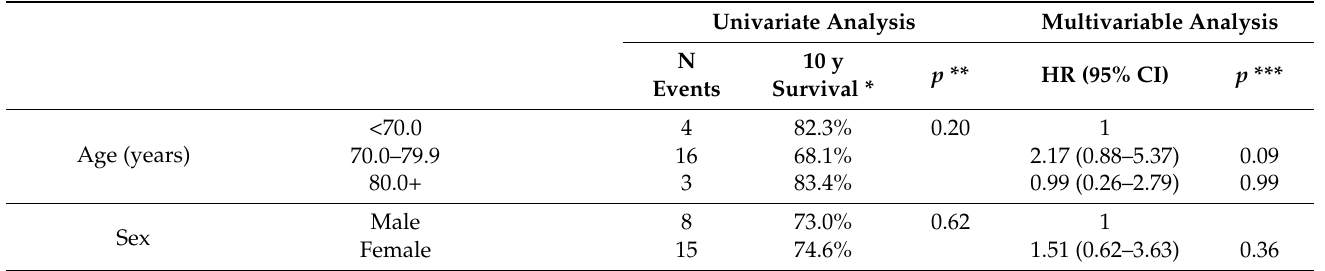
Table 4. Analysis of selected factors associated with disease-free